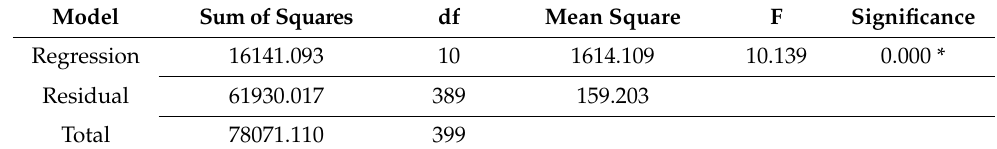
Table 6. ANOVA test for the relationship between GSEOH scores and the study independent variables. Model